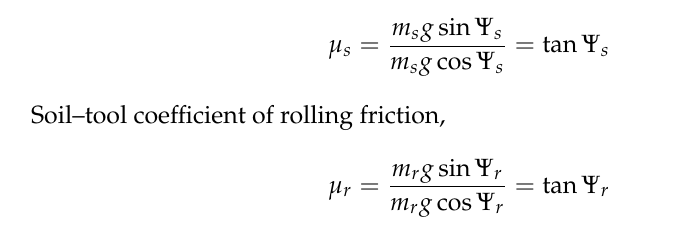
( b ) Figure 11. ( a ) Direct shear box schematic, and ( b ) normal and shear stress expected relationship. In the modified shear box test, the bottom half of the shear box is replaced with a material matching that of the tool or machine part. Normal force and shearing forces are applied the same way as described above. Corresponding normal and shear stresses are plotted as shown in Figure 11b. Given that the cohesive strength of the soil is c , the cross-